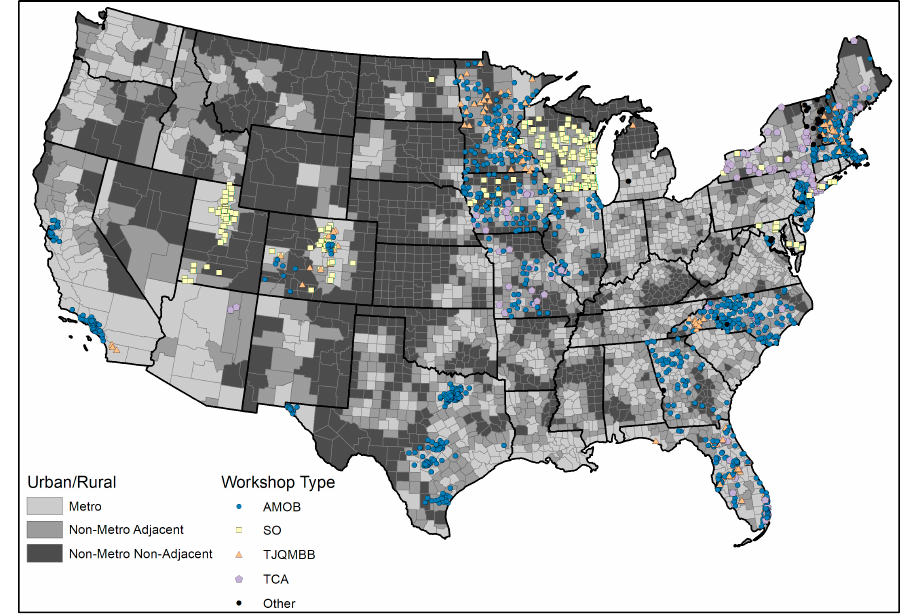
Figure 1. Geospatial distribution of fall prevention program workshops by county and rurality (2014–2017).